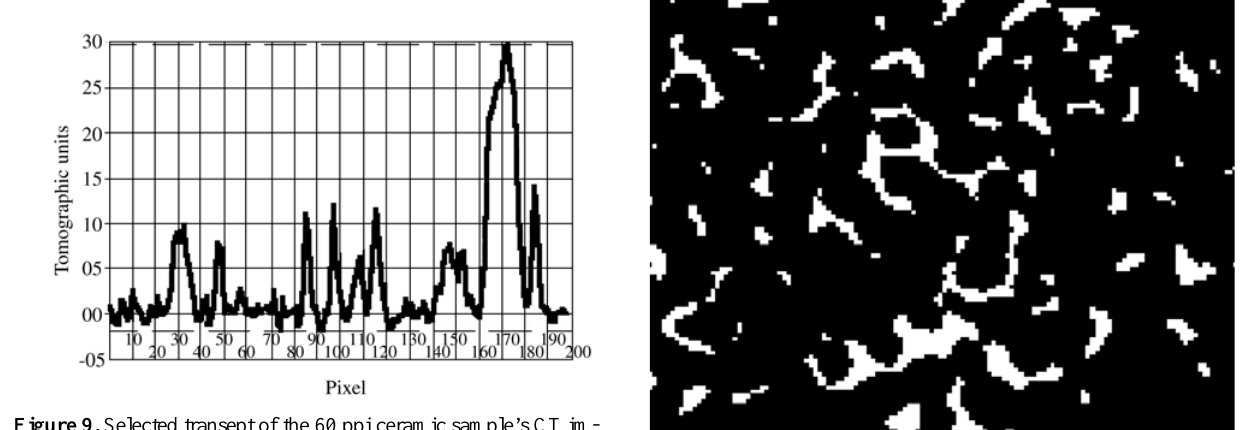
Figure 9. Selected transept of the 60 ppi ceramic sample’s CT im- age.